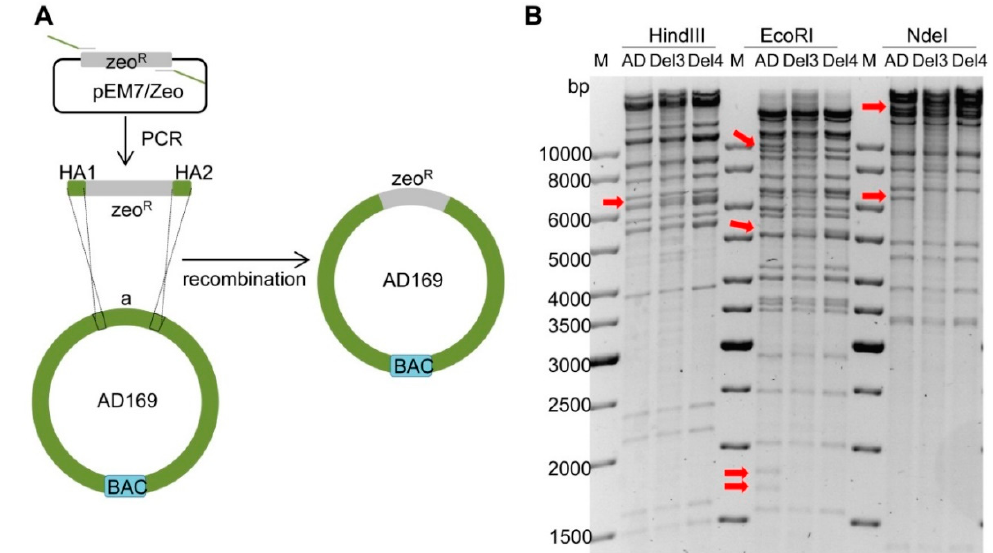
Figure 4. Deletion of fragment ‘a’ in AD169. ( A ) Schematic view of deletion strategy. The zeo R gene was PCR-amplified with primers containing homology arms (HA) homologous to the targeted sequence of AD169. The PCR product was purified and electroporated into recombination-competent GS1783 containing the AD169 BAC. Recombinant clones were selected with zeocin and chloramphenicol. ( B ) BAC DNA was analyzed by restriction digestion with HindIII, EcoRI and NdeI. Arrows indicate the expected alterations in ‘a’ deleted genomes (Del3 and Del4) compared to the parental AD169 (AD) BAC. M, molecular weight standard.